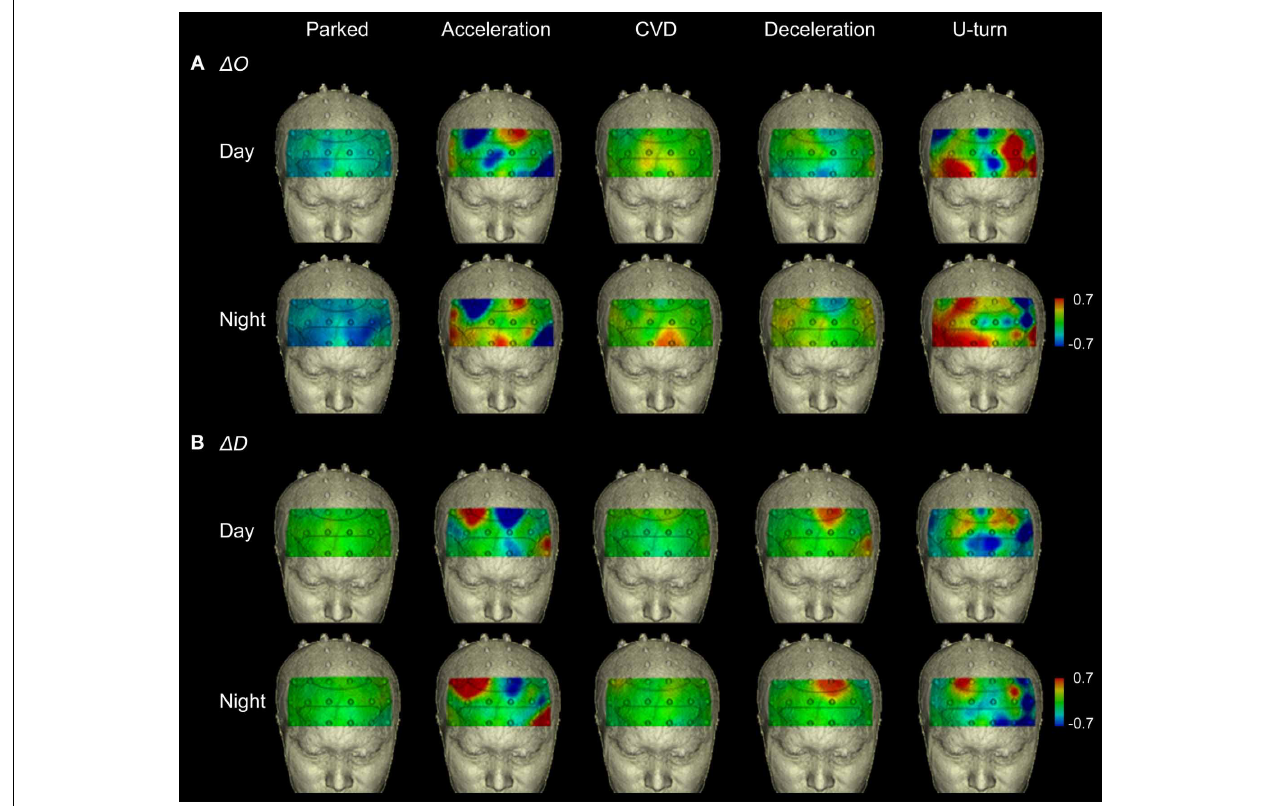
FIGURE 5 | Functional neuroimages of (cid:2) O and (cid:2) D during actual driving. Functional imaging of (cid:2) O (A) and (cid:2) D (B) from the prefrontal cortex (Ch 1-27), during all parts of the experimental task. Dotted lines on the images